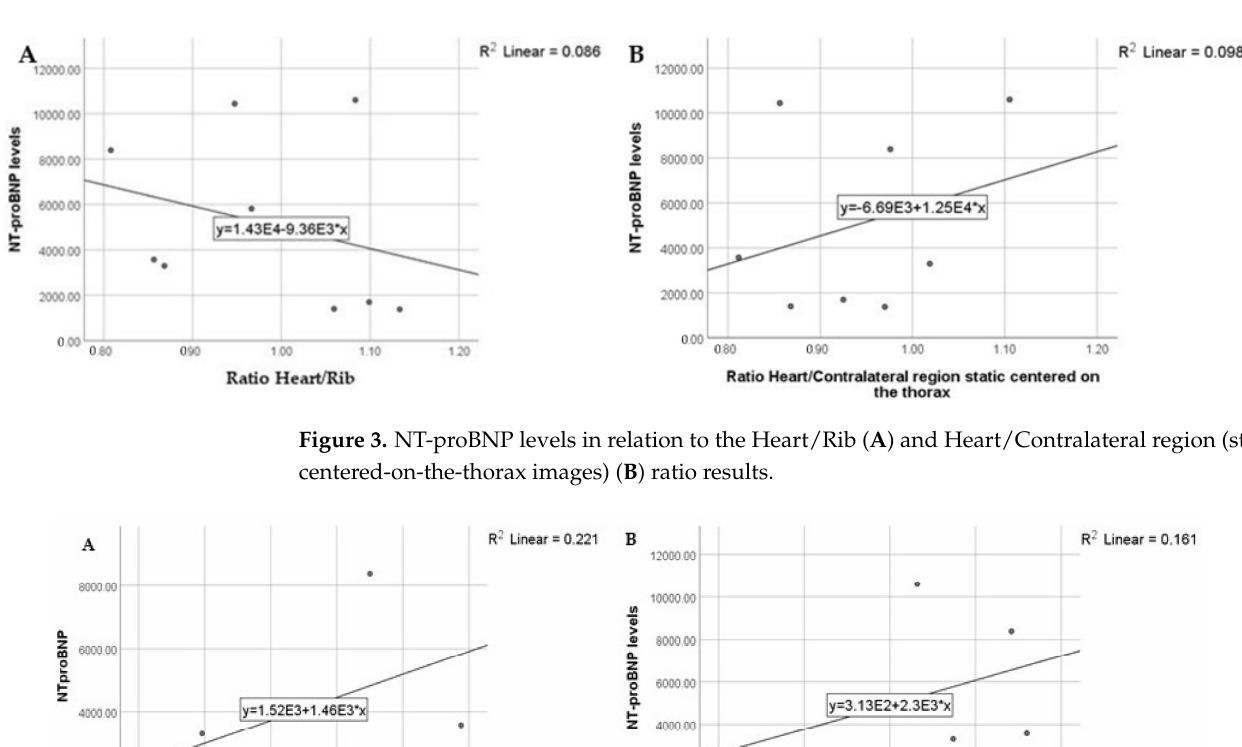
Table 7. Urea and creatinine dosage levels for ATTR patients.